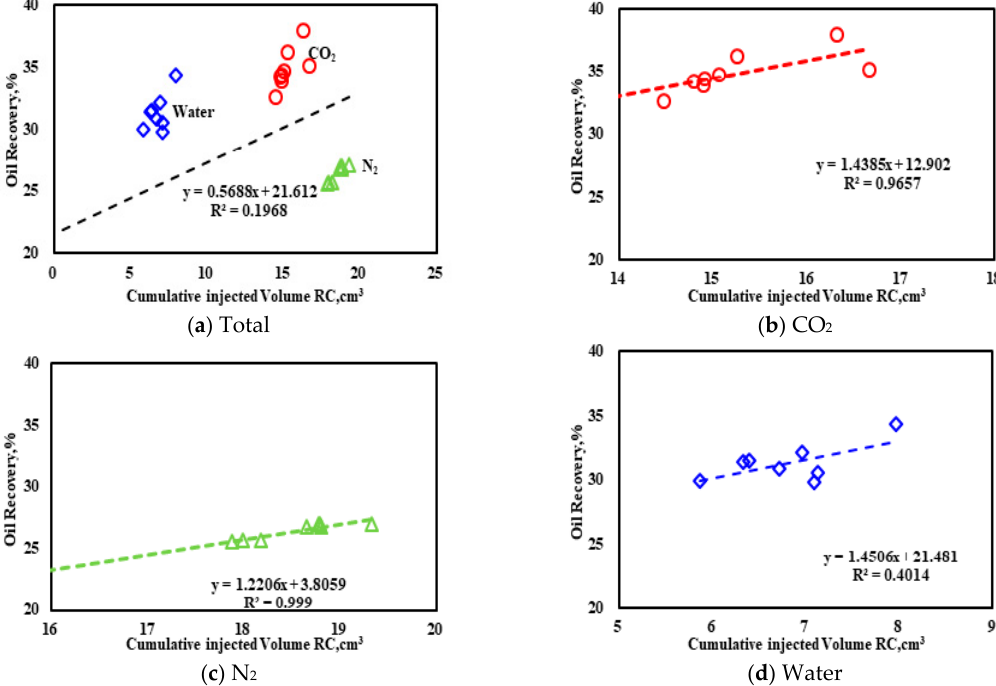
Figure 11. Relationship between injection volume RC and oil recovery in huff-‘n-puff mode.